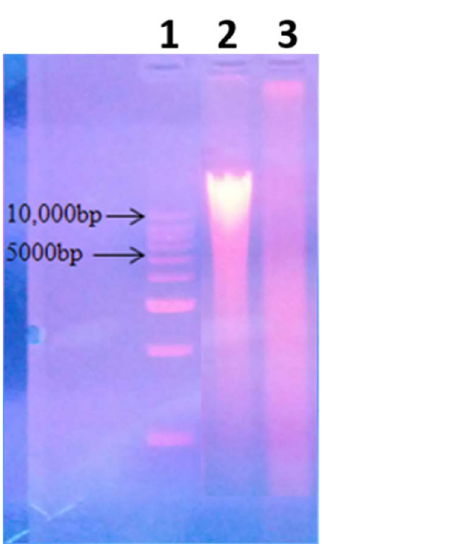
Fig. 1. Lane 1: 10 kb DNA ladder, 2: Metagenomic DNA (Panipat) & 3: Metagenomic DNA Restricted digested with Sau3A1